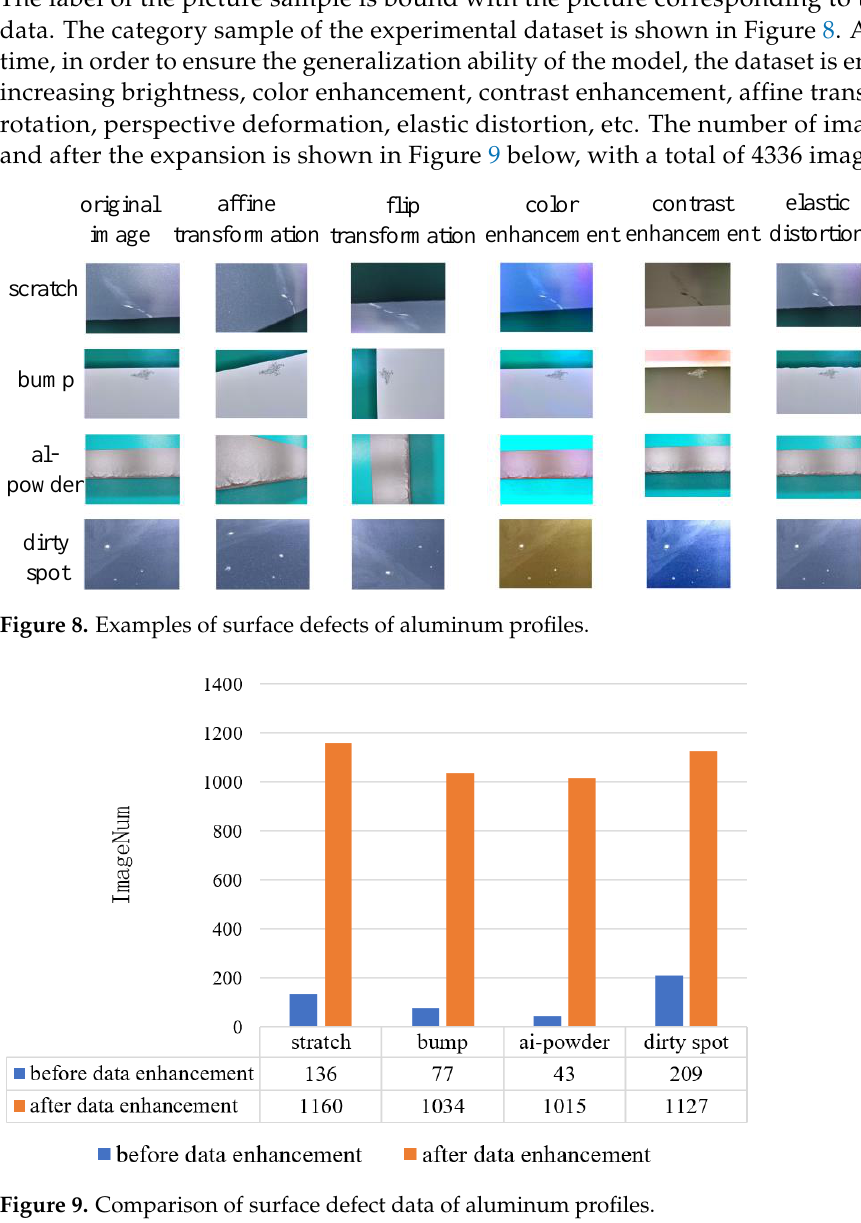
Table 1. Division of dataset of surface defects of aluminum profiles. Category